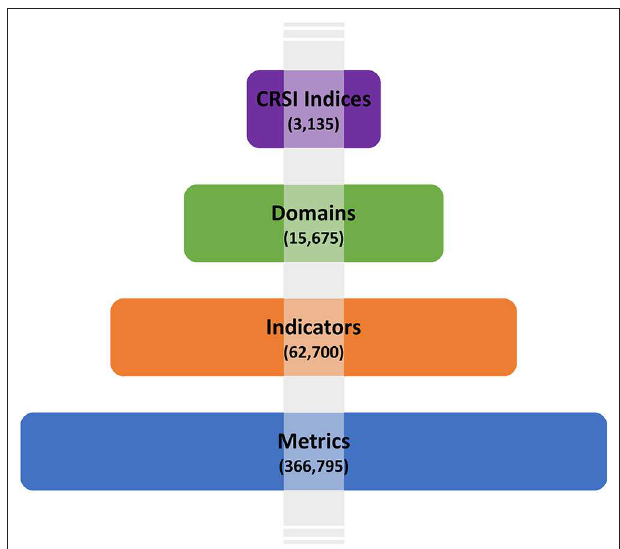
FIGURE 4 | A diagram illustrating the relationship of CRSI components and their contribution to the over quantity of demonstration